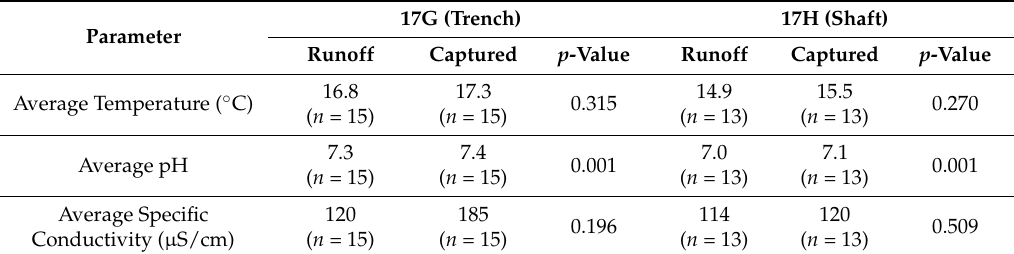
Table 4. In situ water quality